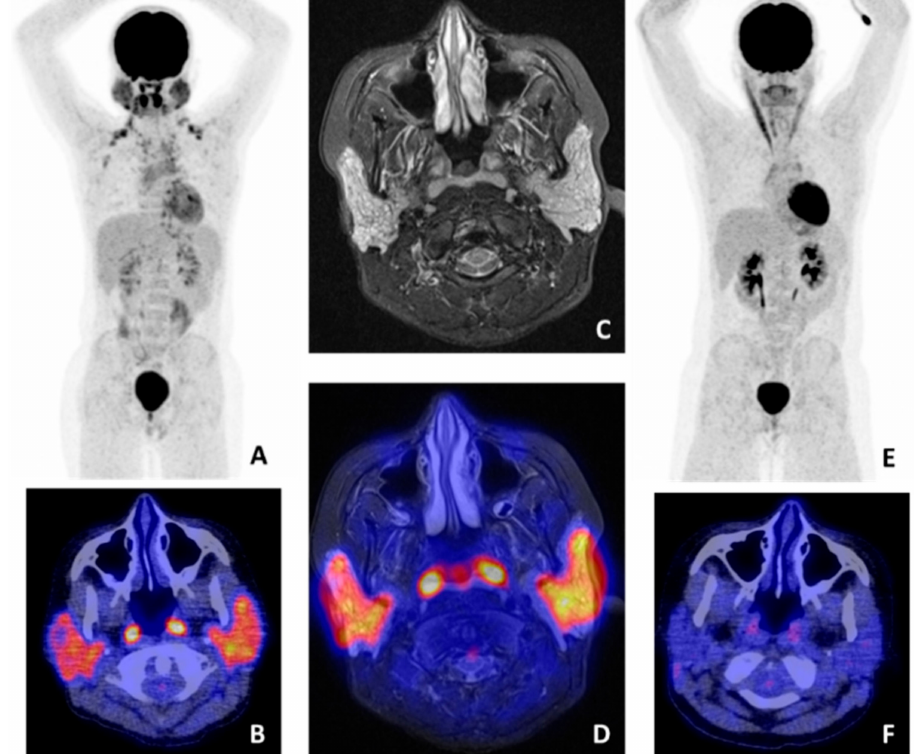
Figure 3. 18 F-fluorodeoxyglucose (FDG) positron emmison tomography / computed tomography (PET / CT) and magnetic resonance imaging (MRI) findings in a pSS patient with salivary gland mucosa associated lymphoid tissue (MALT) lymphoma. ( A ) Whole-body FDG-PET showing high heterogeneous FDG uptake in both parotid and submandibular glands. No other pathological lesions were found (axillary and clavicular regions with increased uptake represent brown fat). ( B ) FDG-PET / CT image showing pathological uptake in the parotid glands and physiological uptake in the tonsils. ( C ) MRI stir sequence showing a pathological, heterogeneous aspect of both parotid glands. ( D ) Manually fused FDG-PET / MRI image, showing pathological uptake in the parotid glands and physiological uptake in the tonsils. ( E ) Whole-body FDG-PET and ( F ) FDG-PET / CT image after treatment, showing no pathological uptake in the parotid glands, indicating complete